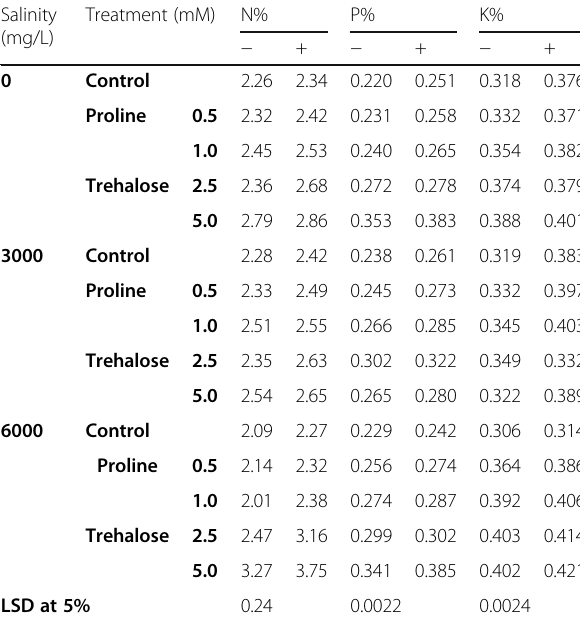
Table 8 Carbohydrate, protein, and oil percentage in the yielded seeds of quinoa plants treated with proline or trehalose with (+) and without ( − ) compost amendment under salinity stress (average of two seasons) Salinity Treatment, mM Carbohydrate % Protein % (mg/L)